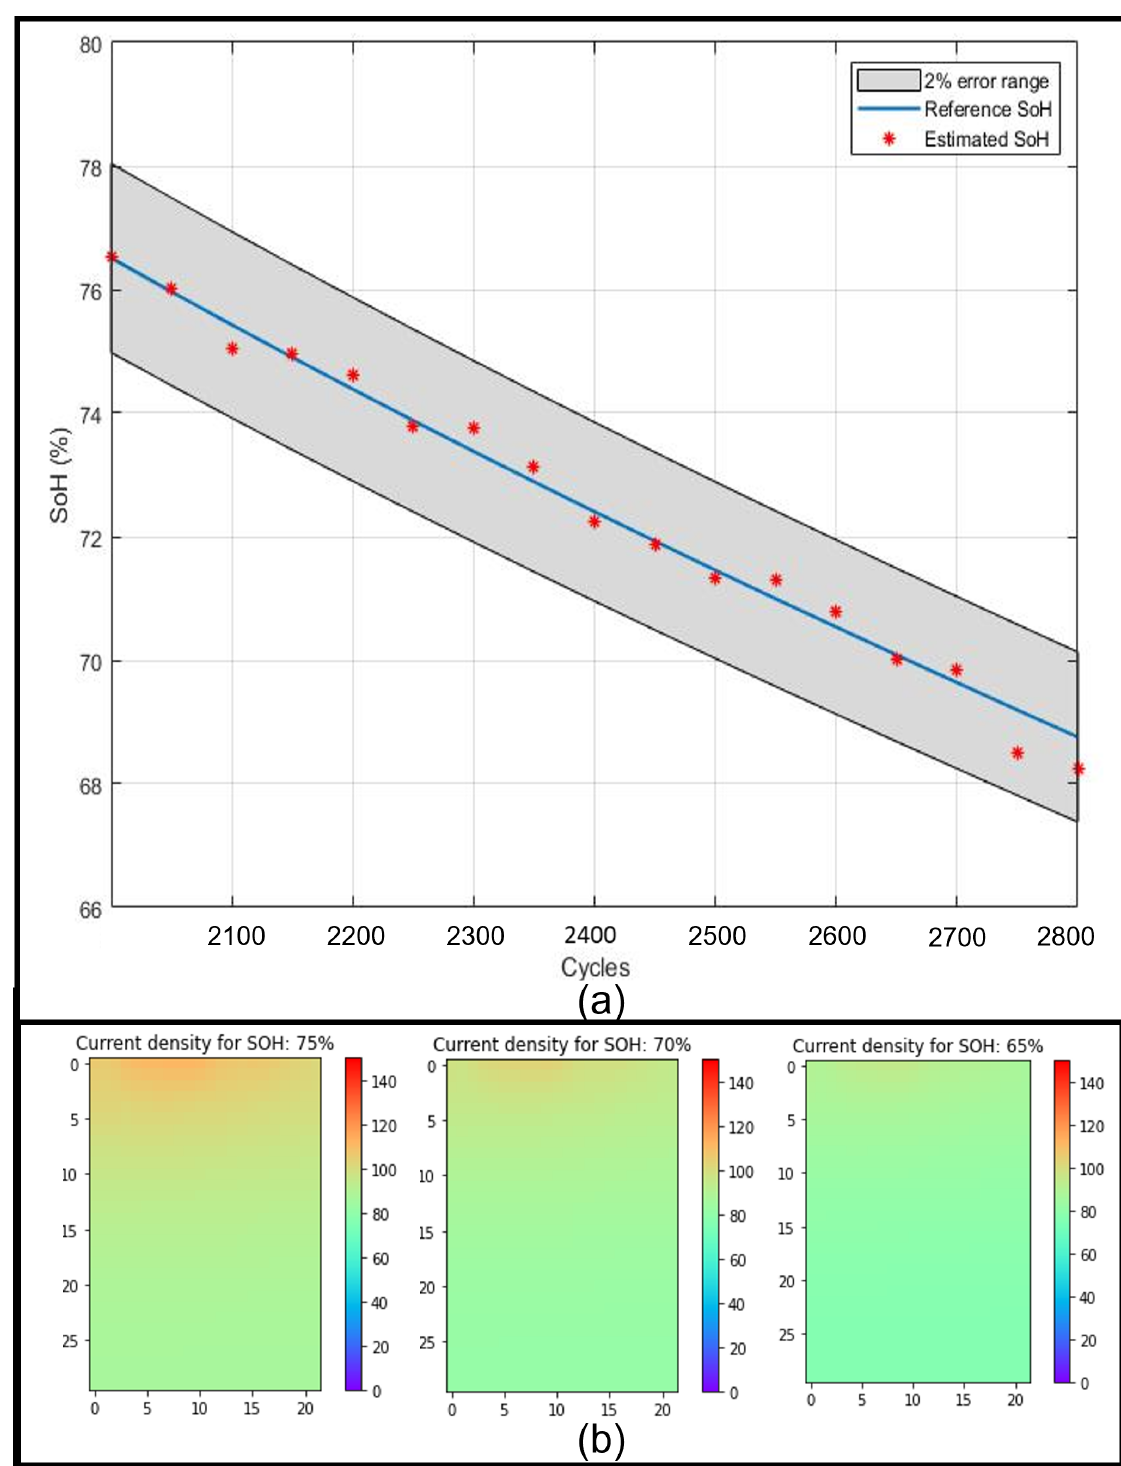
Figure 12. ( a ) SoH(%) estimation results for an aged cell. ( b ) Captured CDIs from the aged